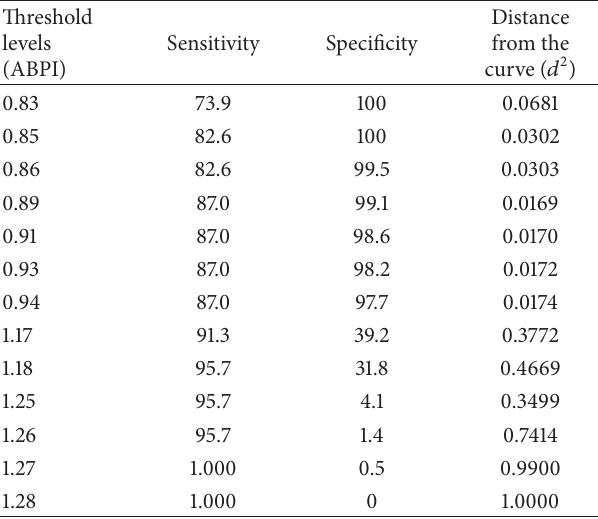
Table 3: Sensitivity and specificity for selected threshold levels of levels of ABPI for detecting a ≥ 50% narrowing of arterial luminal diameter anywhere in the lower limb.